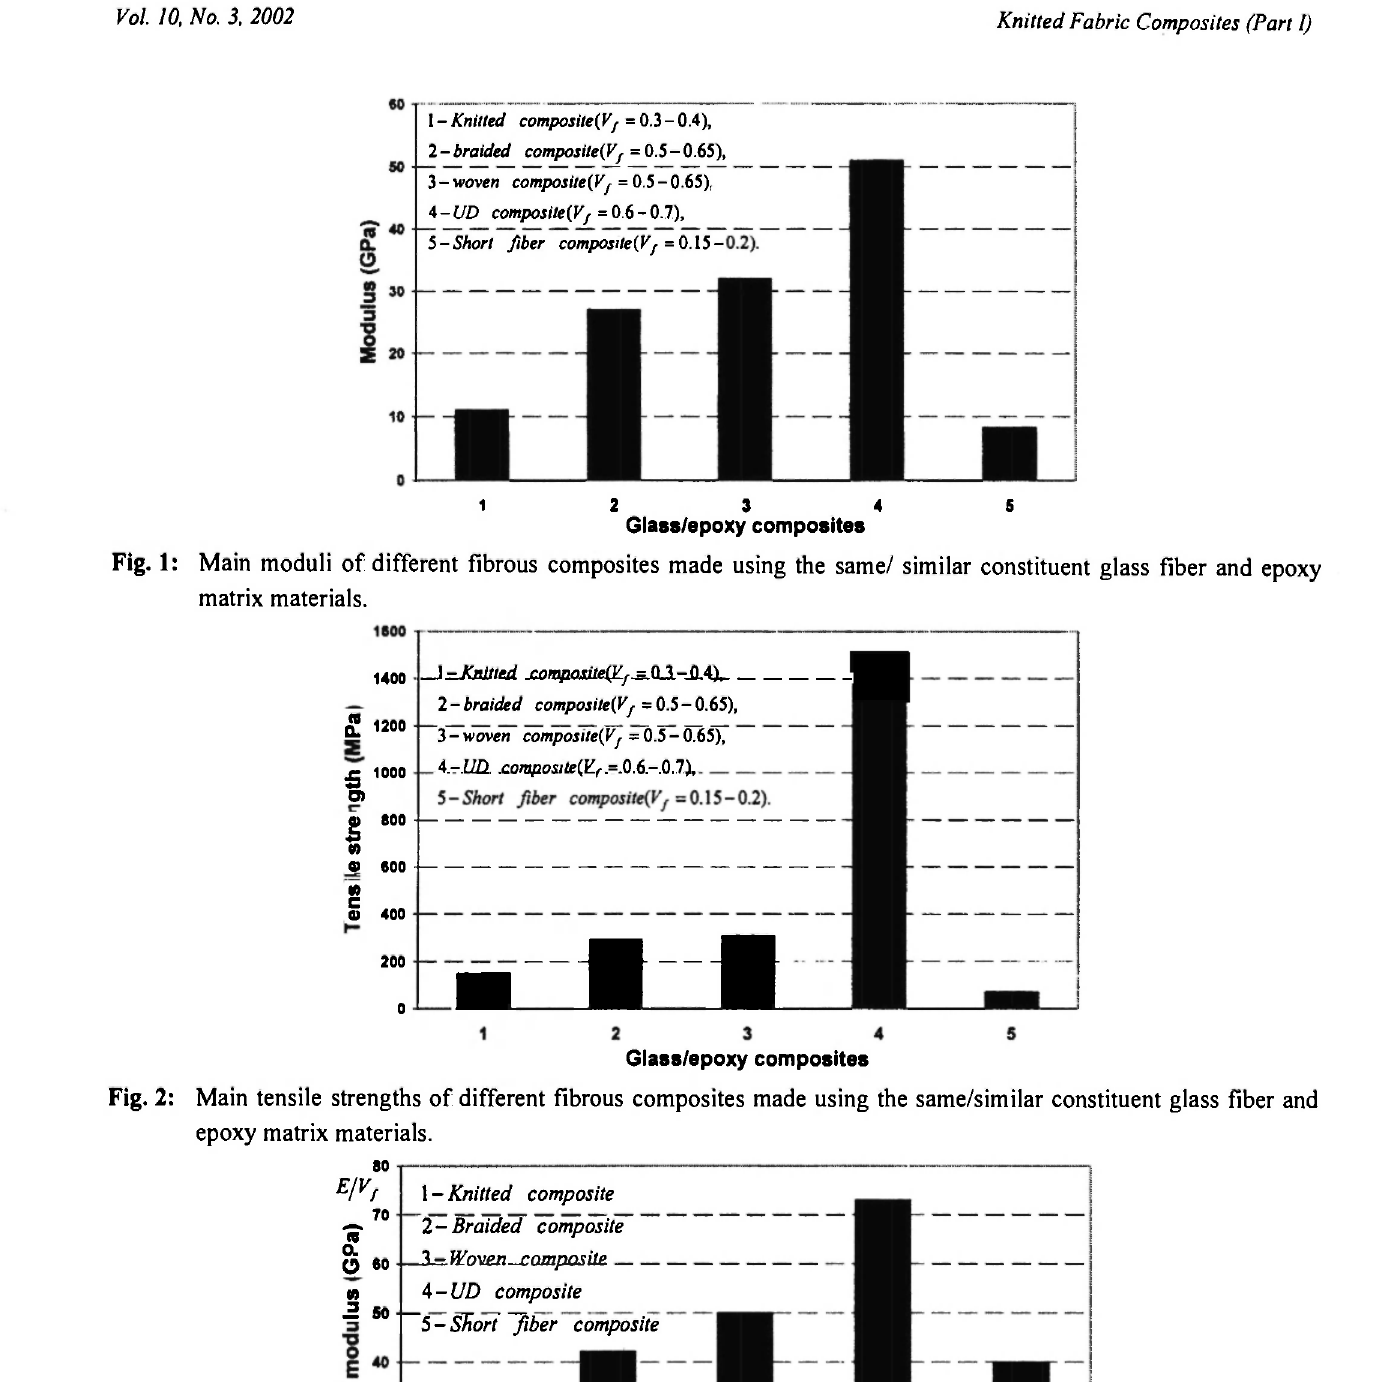
Fig. 3: Normalized (with respect to the fiber volume fraction) modulus of different fibrous composites in their main